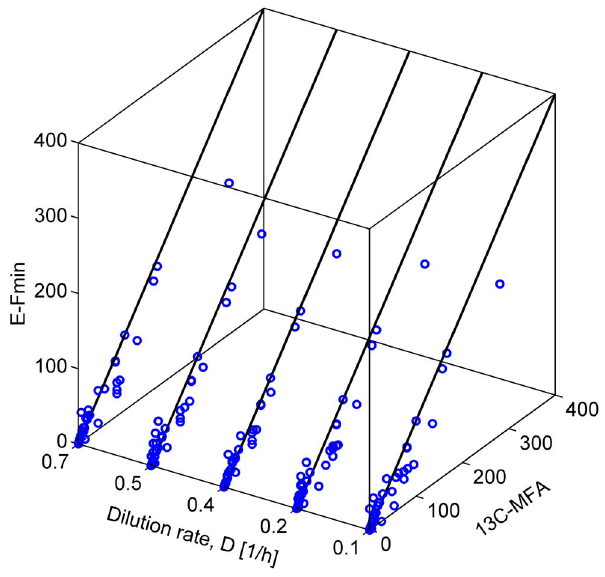
Figure 4. E-Fmin predictions of intracellular metabolic fluxes in wild-type Escherichiacoli . Shown is a comparison of the metabolic fluxes at varied dilution rates (D; x -axis) as measured using 13 C- metabolic flux analysis ( 13 C-MFA; y -axis) and predicted by E-Fmin ( z - axis). In all cases, flux comparisons were made using their relative values normalized with the glucose uptake flux of 100 mmol/(gDW ?